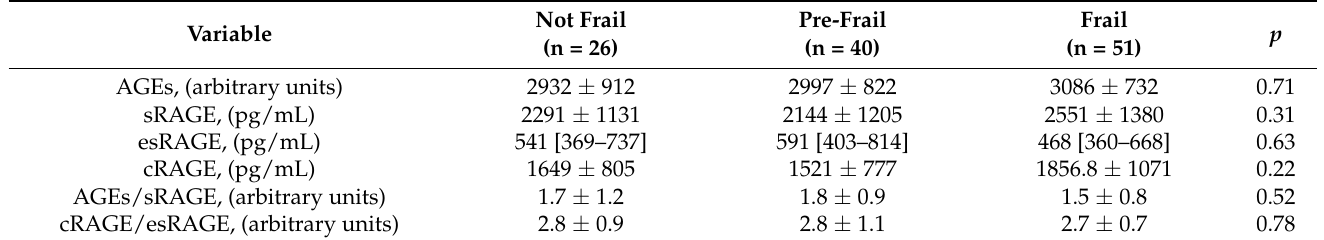
Table 3. Concentration of AGEs and sRAGE isoforms in non-frail, pre-frail and frail CKD